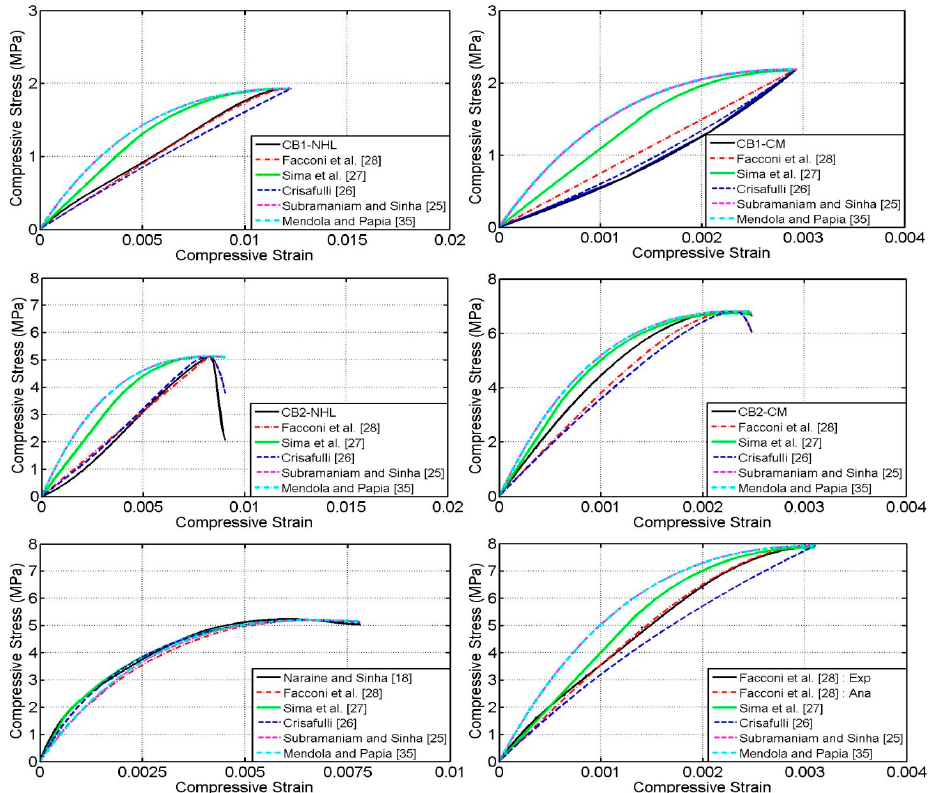
Figure 5. Comparison of experimental and analytical envelop curves.